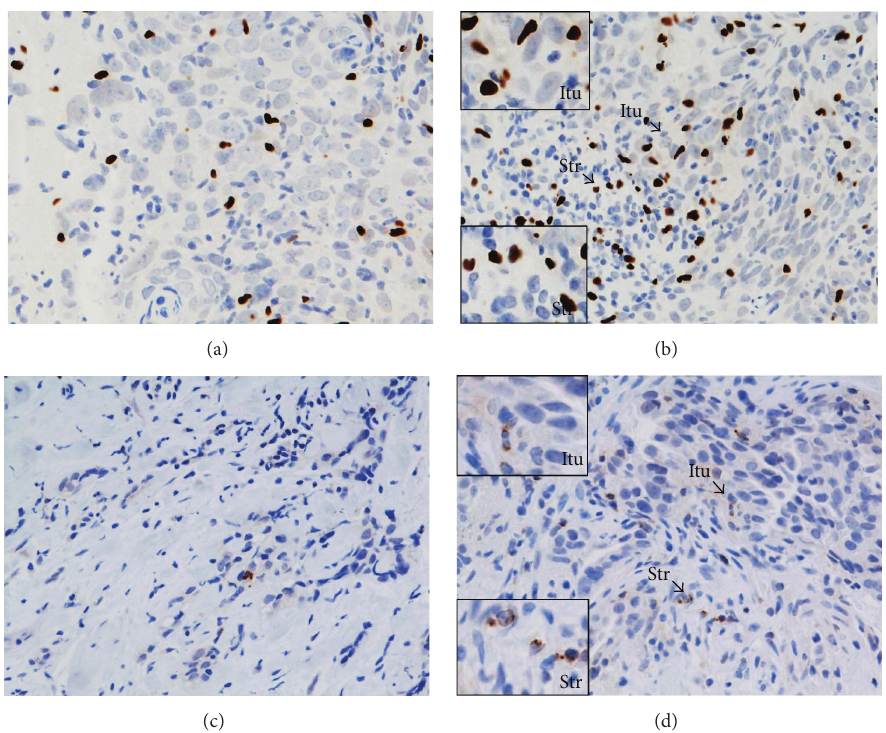
Figure 3: FOXP3 + (a, b) and CTLA-4 + (c, d) Tregs in the sections of LLABCs, using IHC staining, at 400x magnification. Briefly, heat- mediated antigen retrieval was performed using citrate buffer, pH 6 (20mins). The sections were then incubated with MAbs to FOXP3 (Abcam, ab20034) at a concentration of 20 𝜇 g/mL for 30mins at RT and MAbs to CTLA-4 (Santa Cruz Bio, sc-376016) at a 1: 300 dilution for 30 mins at RT. Polymeric HRP-linker antibody conjugate was used as secondary antibody. DAB chromogen was used to visualize the staining. The sections were counterstained with haematoxylin. (a, c) Low level of FOXP3 + , CTLA-4 + Treg infiltration; (b, d) high level of FOXP3 + and CTLA-4 + Treginfiltration.Theaveragenumberofbrownnuclear-stained(FOXP3),membrane-stained(CTLA-4)cells,regardlessofintensity, in contact with tumour cells or within tumour cell nests (Itu: intratumoural) and in the interstitial stroma (Str: stromal) per HPF was counted.